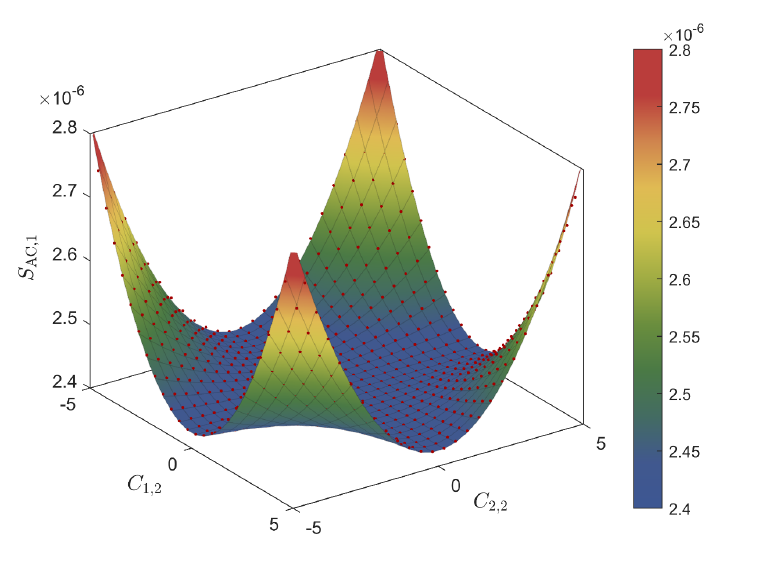
Figure 1 . S AC , 1 (red points) and fitted surface vs. C 1 , 2 , C 2 , 2 with m 1 = m 2 = m , G N m 2 = 10 − 5 , | b | m = 10 , p/m = 0 . 01 . In this non-relativistic regime, the tripartite information is insensitive to the theory. When the C i, 2 is comparable to | b | m at the corner, the entropy grows about 20% . The surface is fitted by 6 . 3 × 10 − 10 C 2 C 2 + 2 . 4 × 10 − 6 , which suggests (3.22) gives the right form of 1 , 2 2 , 2 the | b | m suppressed theory-dependent sub-leading term. The minimal occurs at (0 , 0)